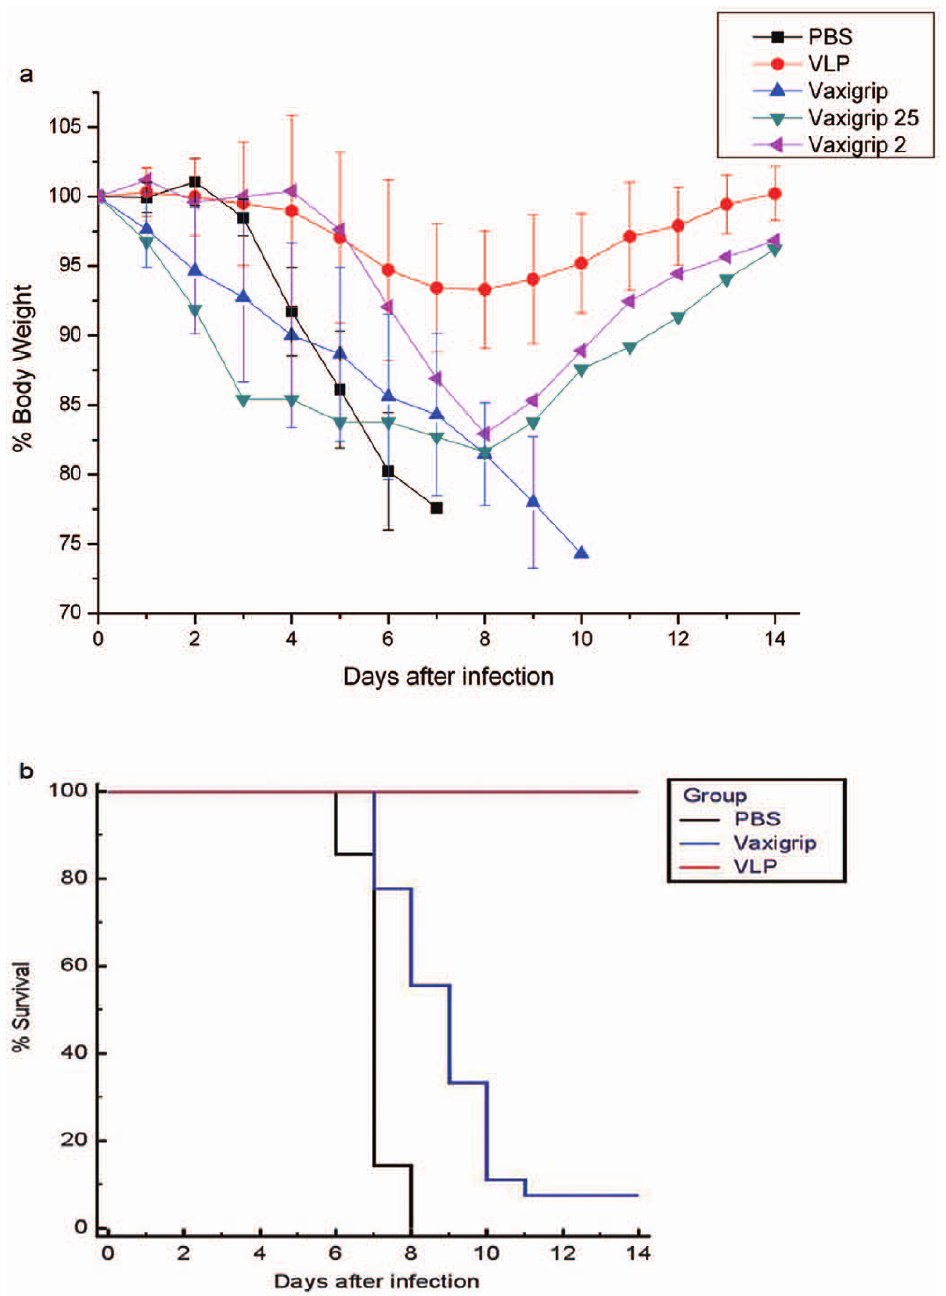
Figure 2. Protection efficacy elicited with H5N1 VLP and seasonal influenza vaccine in mice challenged with 10 MLD 50 of HPAI H5N1 (A/Shenzhen/406H/06). a) Mean and standard deviation of percentage of original body weight in three groups as well as two individual mice ( # 2 and # 25) after challenged with HPAI H5N1 virus. Black line: PBS control group; red line: VLP group; blue line: seasonal influenza vaccine group; purple line: mouse # 2 vaccinated with seasonal influenza vaccine; green line: mouse # 25 vaccinated with seasonal influenza vaccine. b) Survival rates after challenged with HPAI H5N1 virus. Survival rate was calculated based on percent survival within each experimental group. Black line: PBS control group; red line: VLP group; blue line: seasonal influenza vaccine group. The data shown here were the combined results of two individual experiments. The survival curves between different groups were compared by the log-rank test. P values between PBS and seasonal influenza vaccination groups, between PBS and VLP vaccination groups and between seasonal influenza and VLP vaccination groups were 0.0003, 0.0002 and , 0.0001,